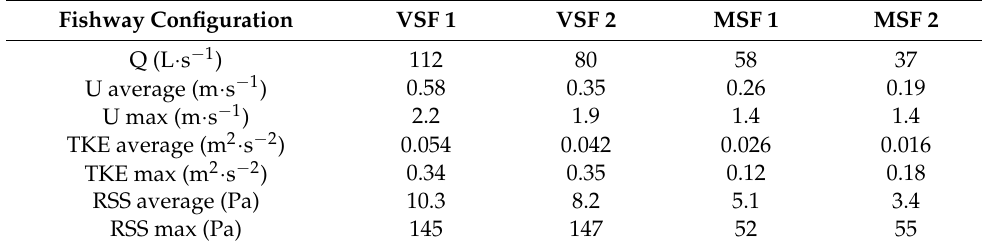
Table 2. Numerical results, discharge, velocity, and turbulence parameters of the four fishway config- urations tested considering the total water volume in a reference pool (pool n. ◦ 3). Q, discharge; U average, volume-averaged mean water velocity magnitude; U max, maximum water velocity magni- tude; TKE average, volume-averaged turbulent kinetic energy; TKE max, maximum turbulent kinetic energy; RSS average, volume-averaged Reynolds shear stress parallel to the bottom component; RSS max, maximum Reynolds shear stress parallel to the bottom component; VSF, vertical slot fishway; MSF, multislot fishway. Fishway Configuration